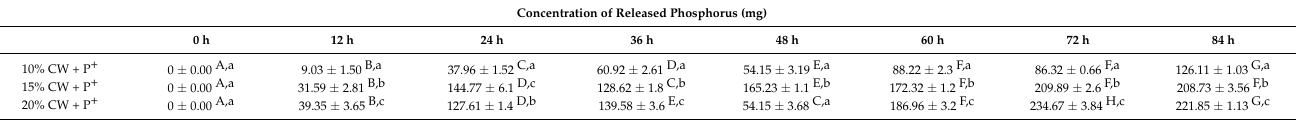
Table 3. Phosphorus concentration (P + ) released into the ruminal fluid by the oleogels of CW for 84 h.